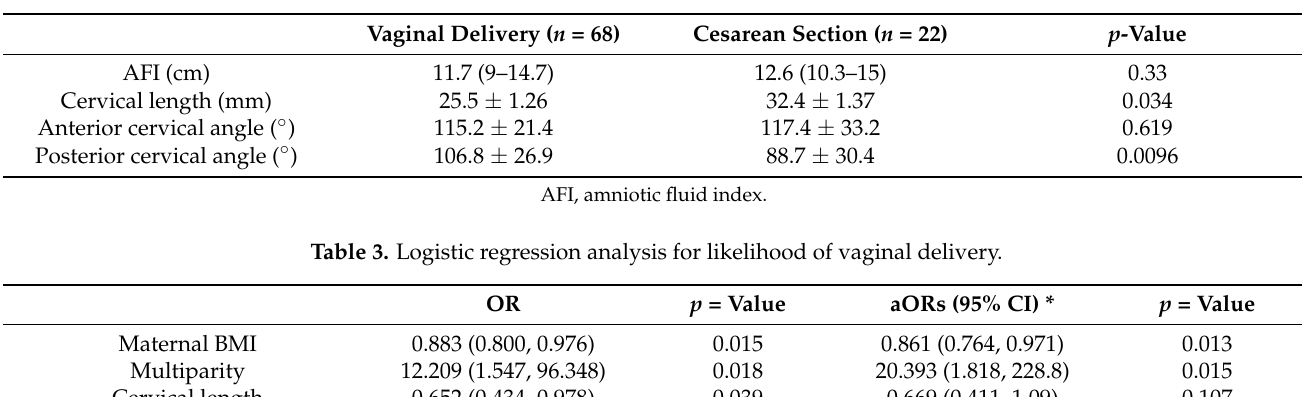
Table 2. Ultrasound results.